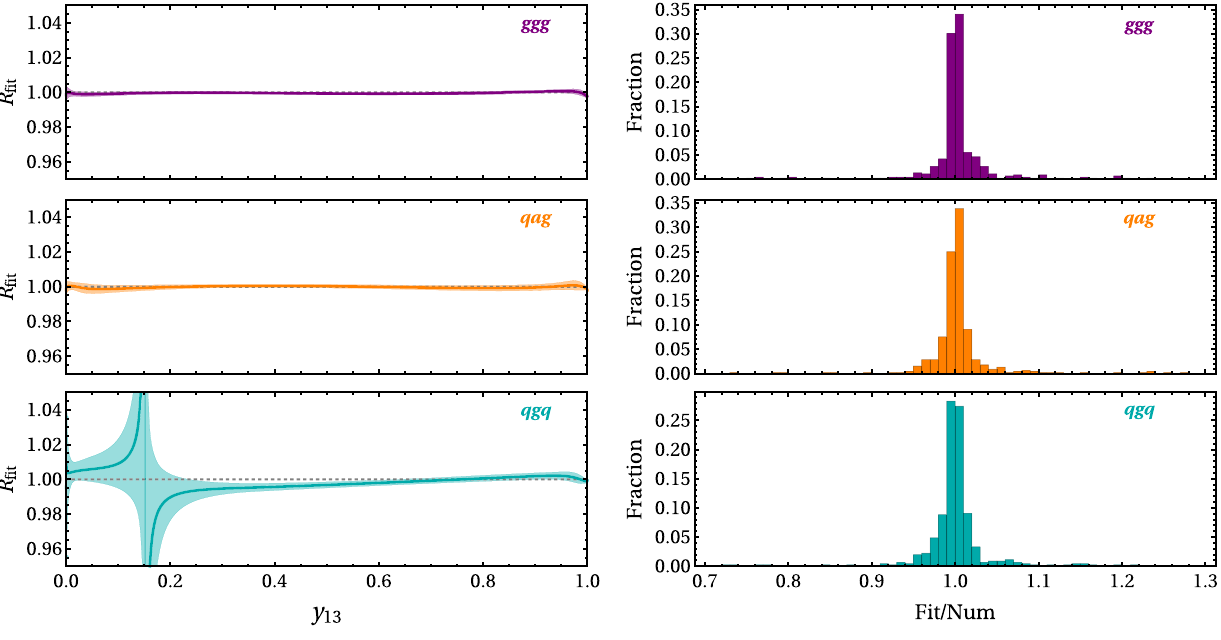
fromthefitsandobtainednumericalresultsfor450randomly-generated phase-space points in the generic kinematics